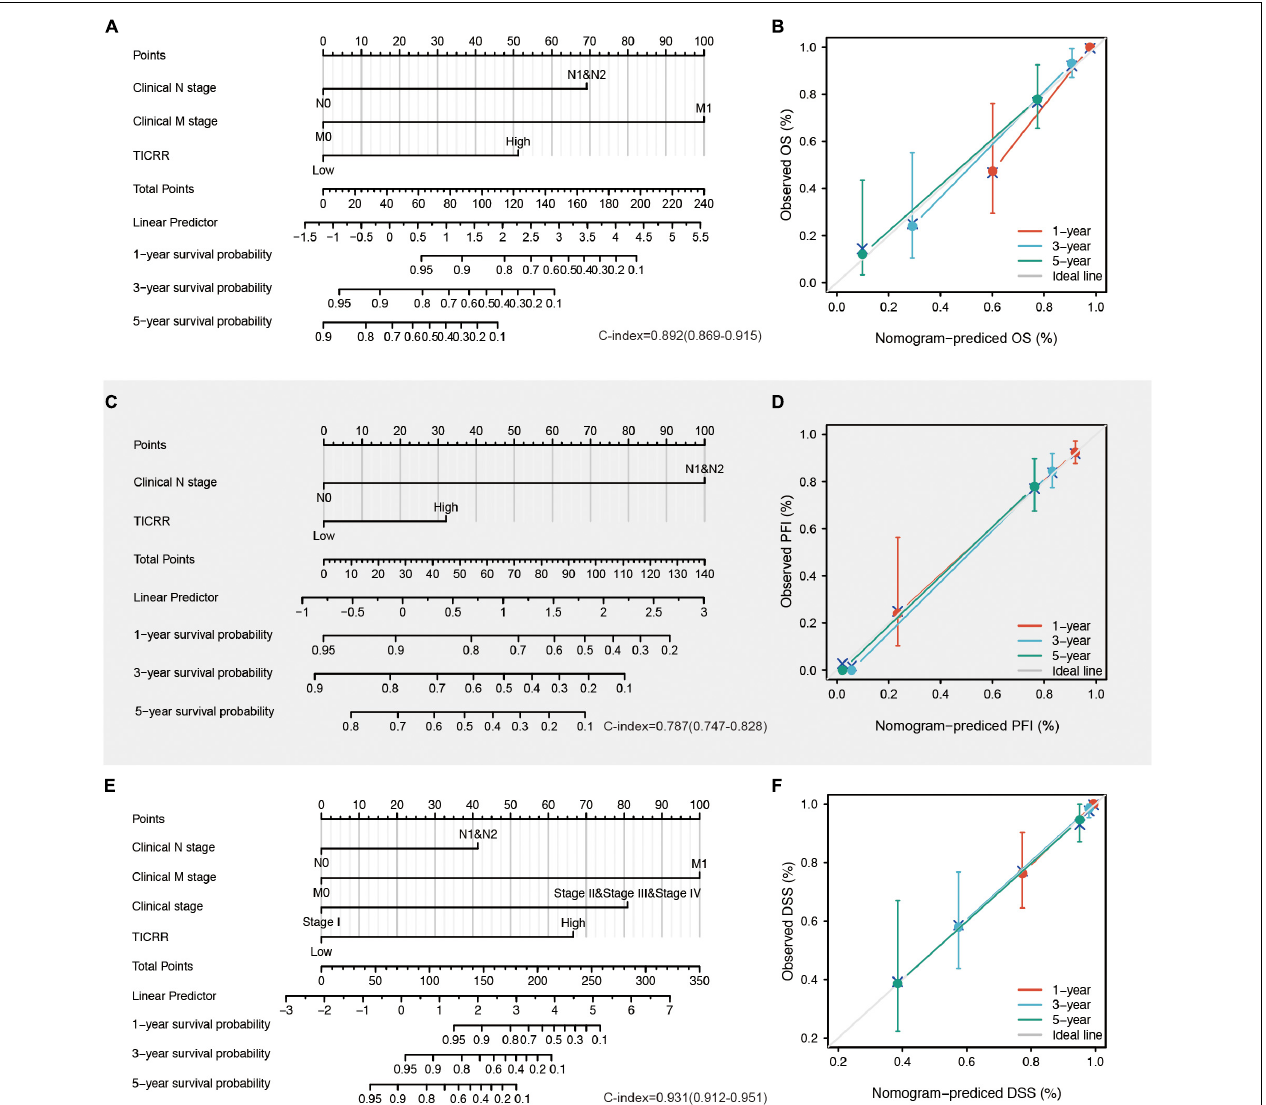
FIGURE 6 | Construction and validation of nomograms based on TICRR expression. Shown are the nomograms constructed to establish TICRR expression-based risk scoring models for 1-, 3-, and 5-year overall survival (A) , progression-free interval (C) , and disease-specific survival (E) . Calibration plots validating the efficiency of nomograms for overall survival (B) , progression-free interval (D) , and disease-specific survival (F) . OS, overall survival; PFI, progression-free interval; DSS, disease-specific survival.